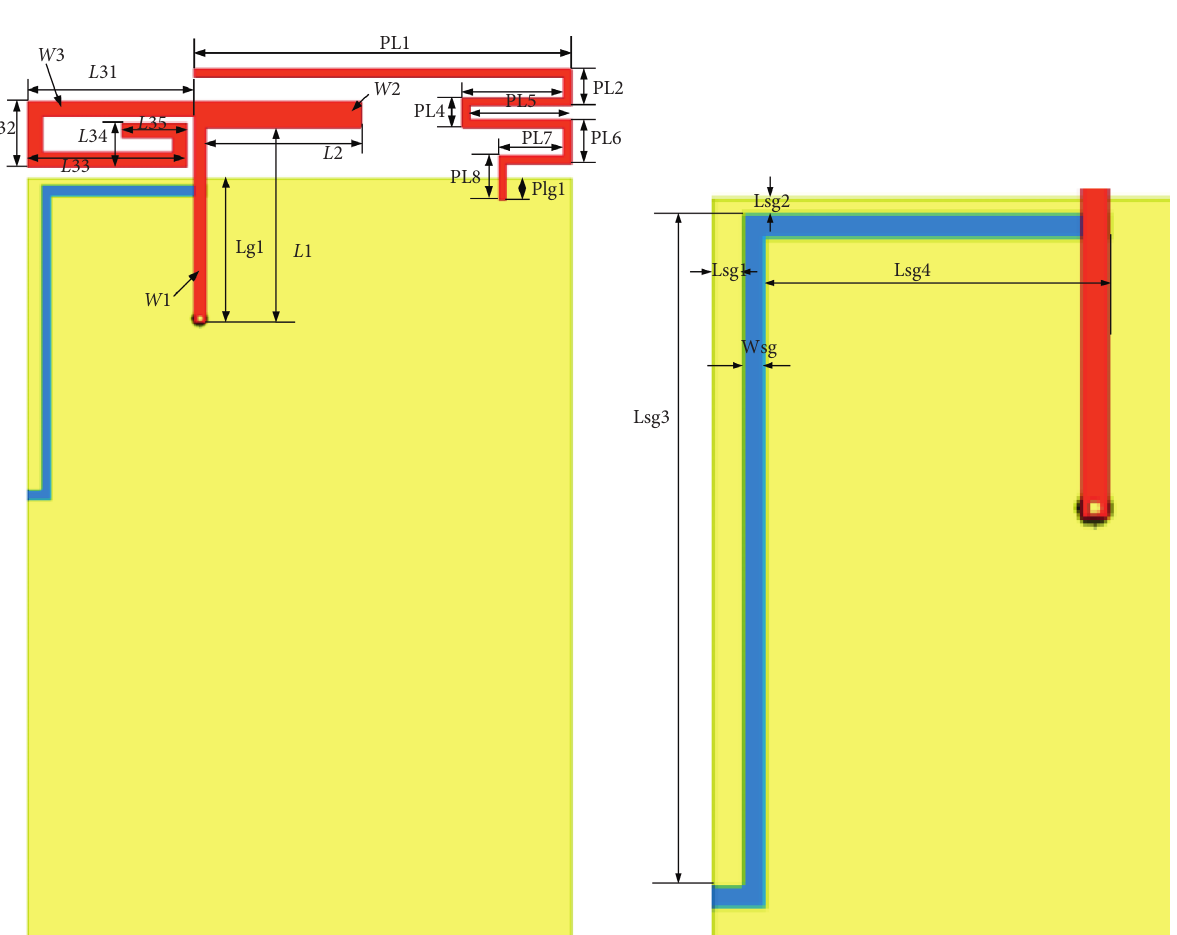
Figure 3: Flowchart of optimal design.